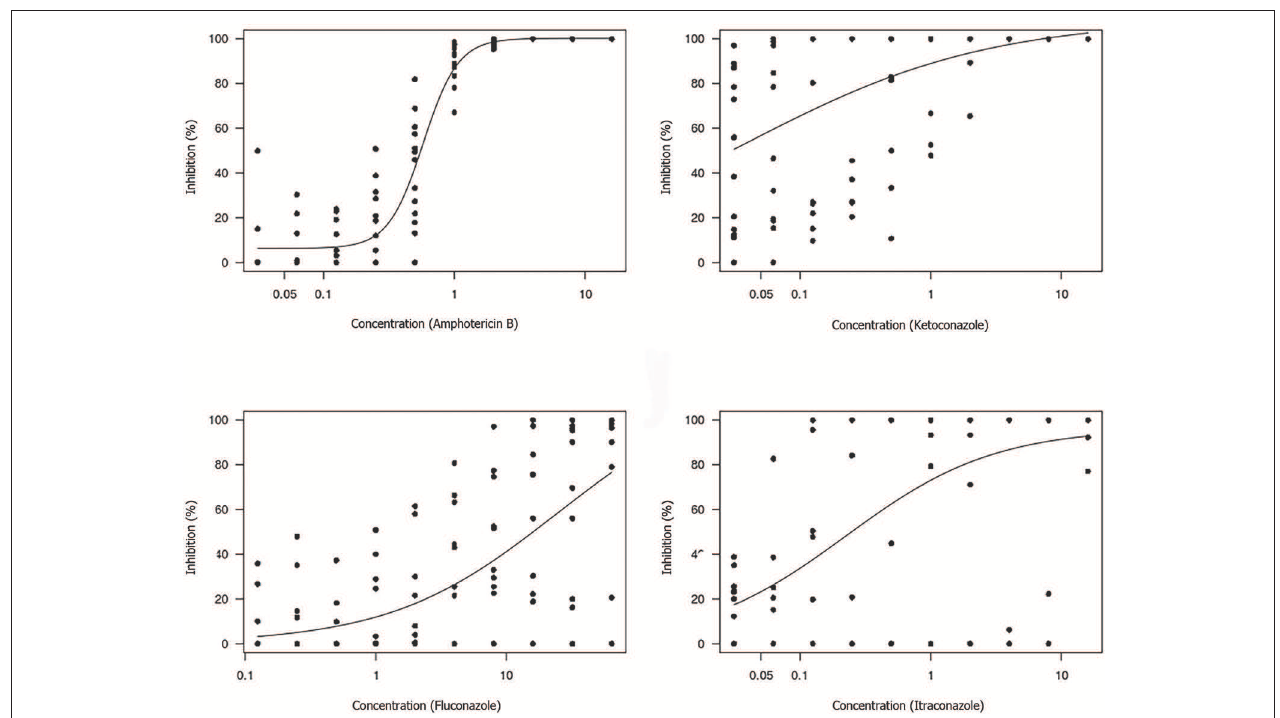
FIGURE 3 | Dose-response curve for each antifungal tested using the broth microdilution technique to determine the EC50 value of M. pachydermatis isolates. The results are expressed in µ